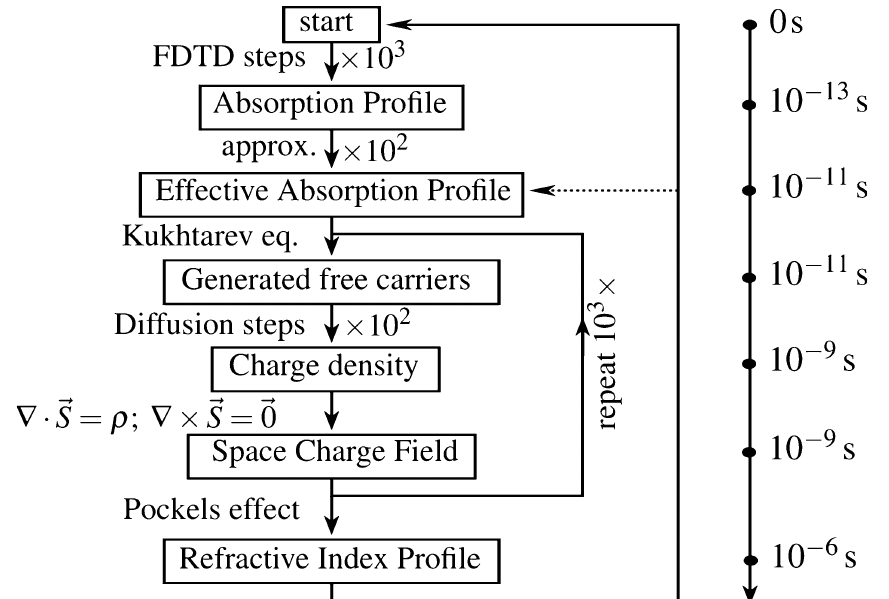
Figure 6. A flowchart of a typical photorefractive FDTD simulation together with typical times in the physical process. Each iterative operation is accompanied by a typical number of iterations. This figure was created with